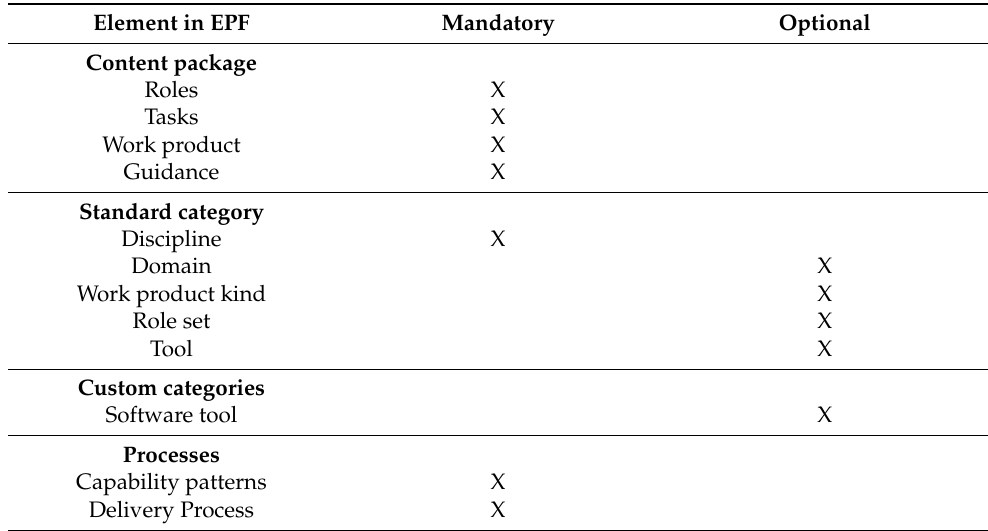
Figure 5. Example of a profile on EPF Composer. Table 2. EPF Composer usage